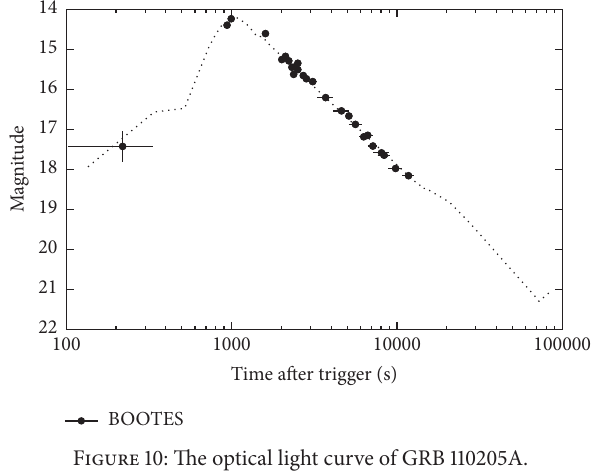
Figure 10: The optical light curve of GRB 110205A.